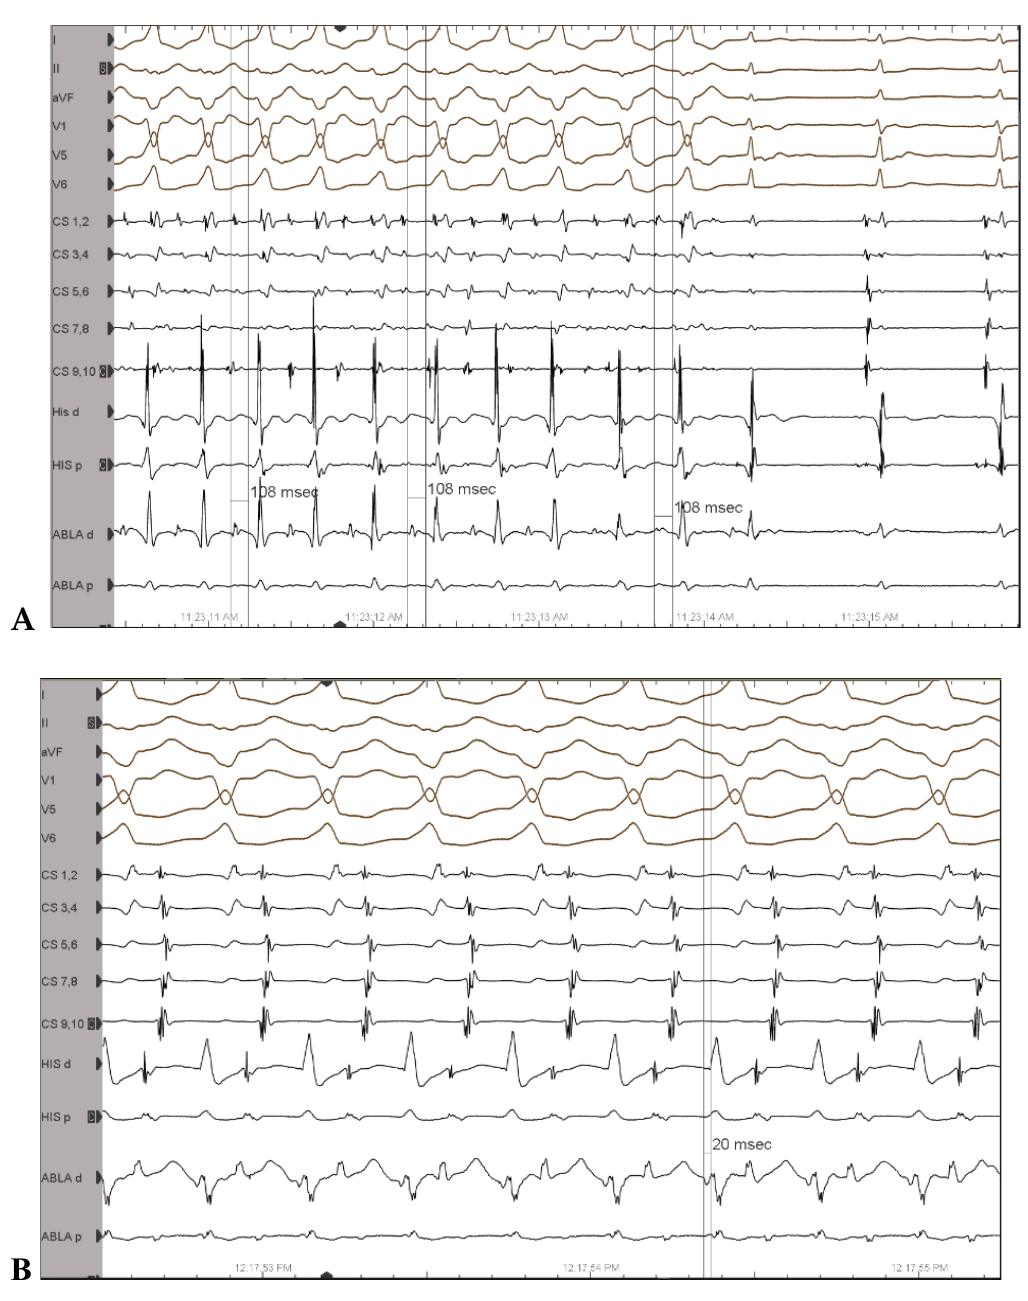
Figure 3. Limited 3D atrial mapping during orthodromic AVRT ( left ) and limited 3D ventricular activation mapping during antidromic AVRT ( right ); pink dots: earliest atrial and ventricular sig- nals, respectively; dark-blue dots: tricuspid annulus; light blue dots: mark the limit from which ven- tricular electrograms no longer precede the surface QRS.